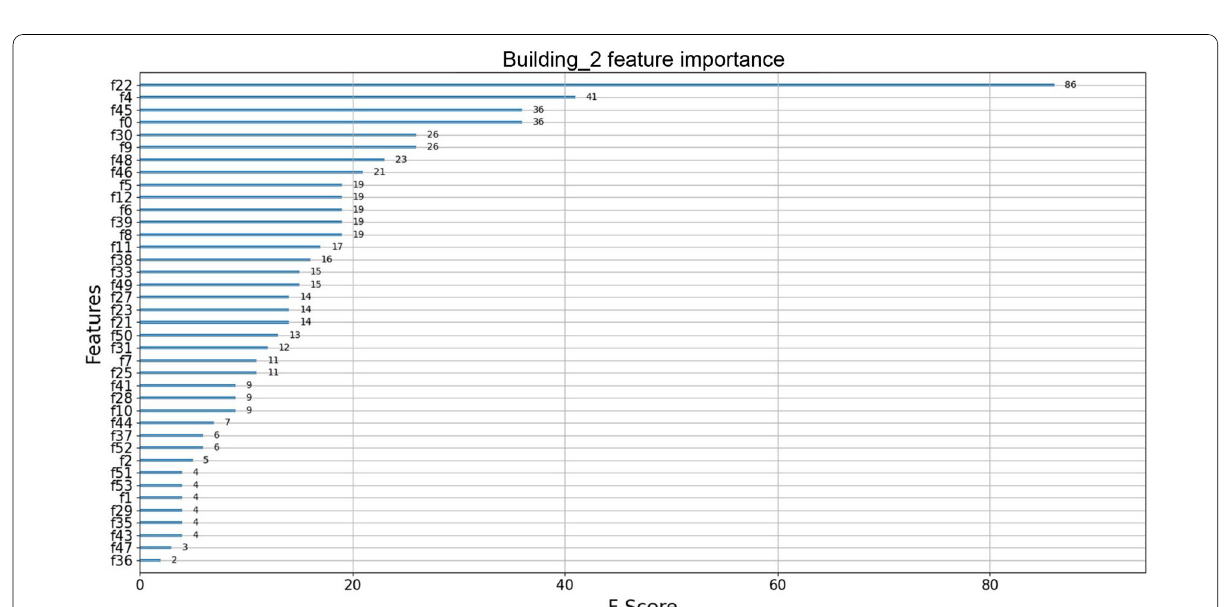
Fig. 12 The score of each feature using the data which comes from